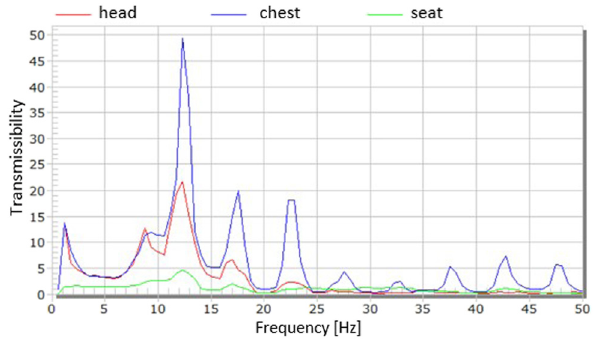
Figure 4: The range of transmissibility of the vertical vibrations of the whole body to the seat, chest, and head as a function of the frequency for the 5 Hz excitation.